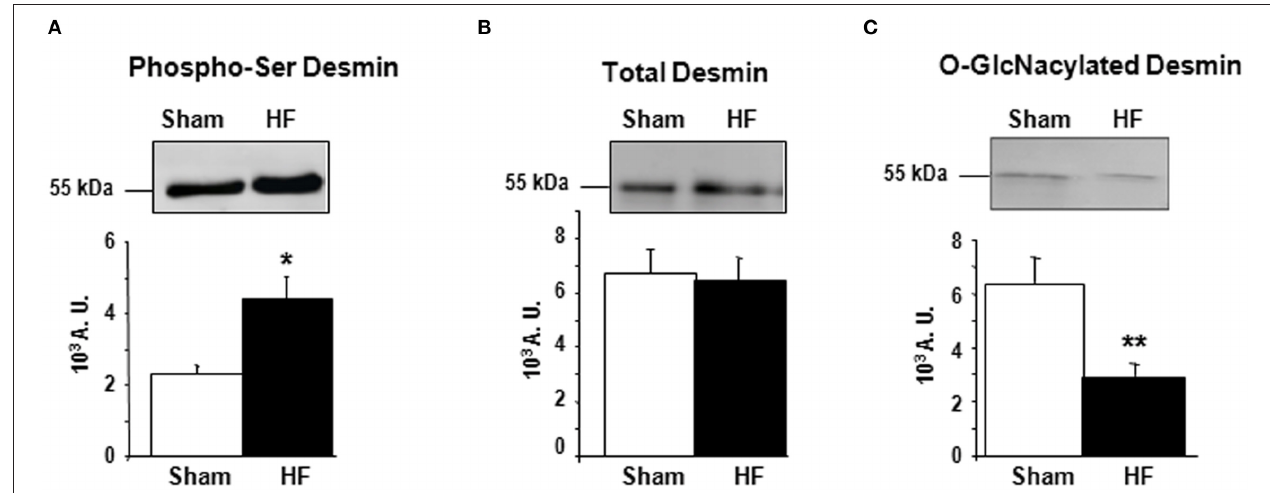
FIGURE 1 | Post-translational modifications of desmin of LV from HF-rats. Quantification of Ser-phosphorylated desmin (A) , total desmin levels (B) , and O-GlcNAcylated desmin levels (C) in LV (50 µ g) of sham- ( n = 11) (white box) and HF- ( n = 11) (black box) rats at 2 months after MI. The positions of molecular weight are indicated as kilodalton (kDa) on the left. An internal standard was loaded in each gel for the standardization and quantification. Graphs show mean ± SEM values expressed in arbitrary units (A.U.). * P < 0.05; ** P < 0.01.